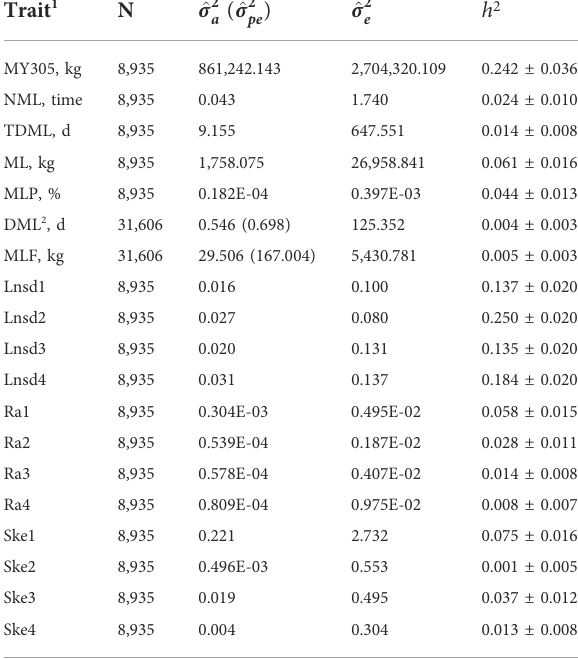
TABLE 2 Estimates of additive genetic variance ( ^ σ 2 a ), permanent environment variance ( ^ σ 2 pe ), residual variance ( ^ σ 2 e ), and heritability ( (cid:12) h 2 ) for 305 days milk yield, milk loss traits, and variability